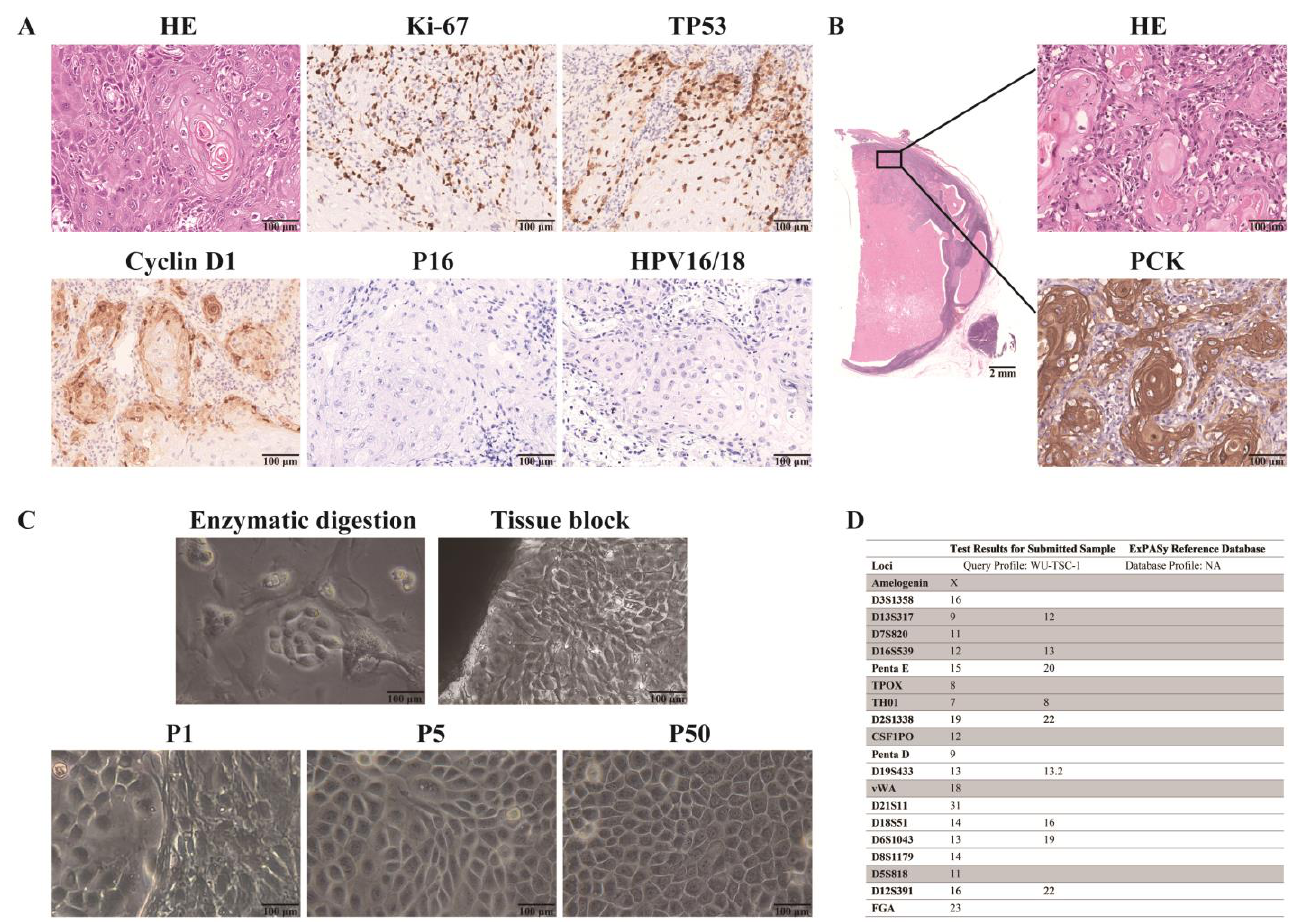
Figure 1. Histological features of the donor and establishment of WU-TSC-1: ( A ) HE staining showed pathology features of the original tumor. Immunohistochemical staining and in situ hybridization exhibited it was positive for Ki-67, Cyclin D1 and TP53, but negative for P16 and HPV16/18 (200 × ). ( B ) Cervical lymph nodes metastasis stained with HE and Pan Keratin marker (200 × ). ( C ) Primary cell culture through enzymatic digestion and block culture methods (upper). Epithelioid morphology of established tongue SCC cells at passage 1, 5 and 50, respectively (lower) (200 × ). ( D ) Analysis of STR markers in WU-TSC-1 cell